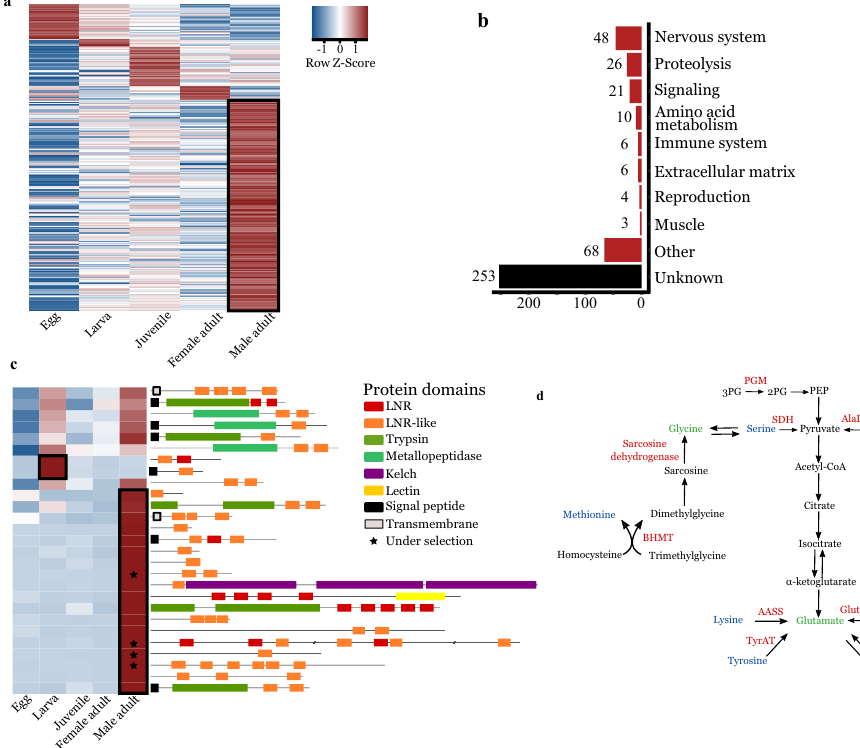
Figure 4. Differential expression analysis of the Oithona nana transcriptome. ( a ) Heatmap of the 1233 significantly differentially expressed genes in at least one of the five developmental stages. ( b ) Func- tional annotation distribution of 445 genes explicitly overexpressed in male adults. ( c ) Heatmap of the 27 significantly differentially expressed LDPGs and the composition of their protein domains. ( d ) Amino acid conversion to neurotransmitters in O. nana males. Overexpressed enzymes in males are indicated in red, amino acids in blue, and neurotransmitter amino acids in